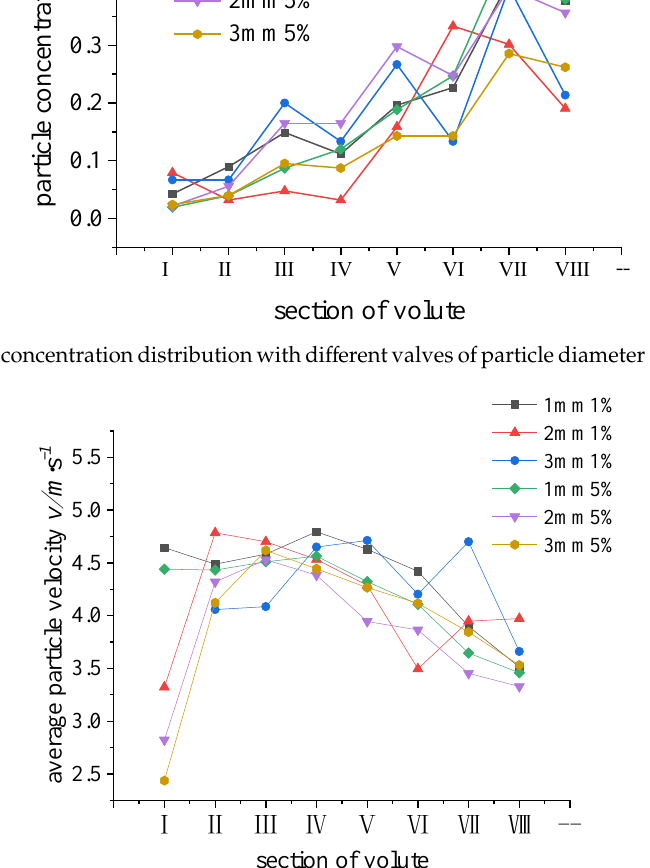
Figure 9. Particle velocity with different valves of particle diameter and concentration.